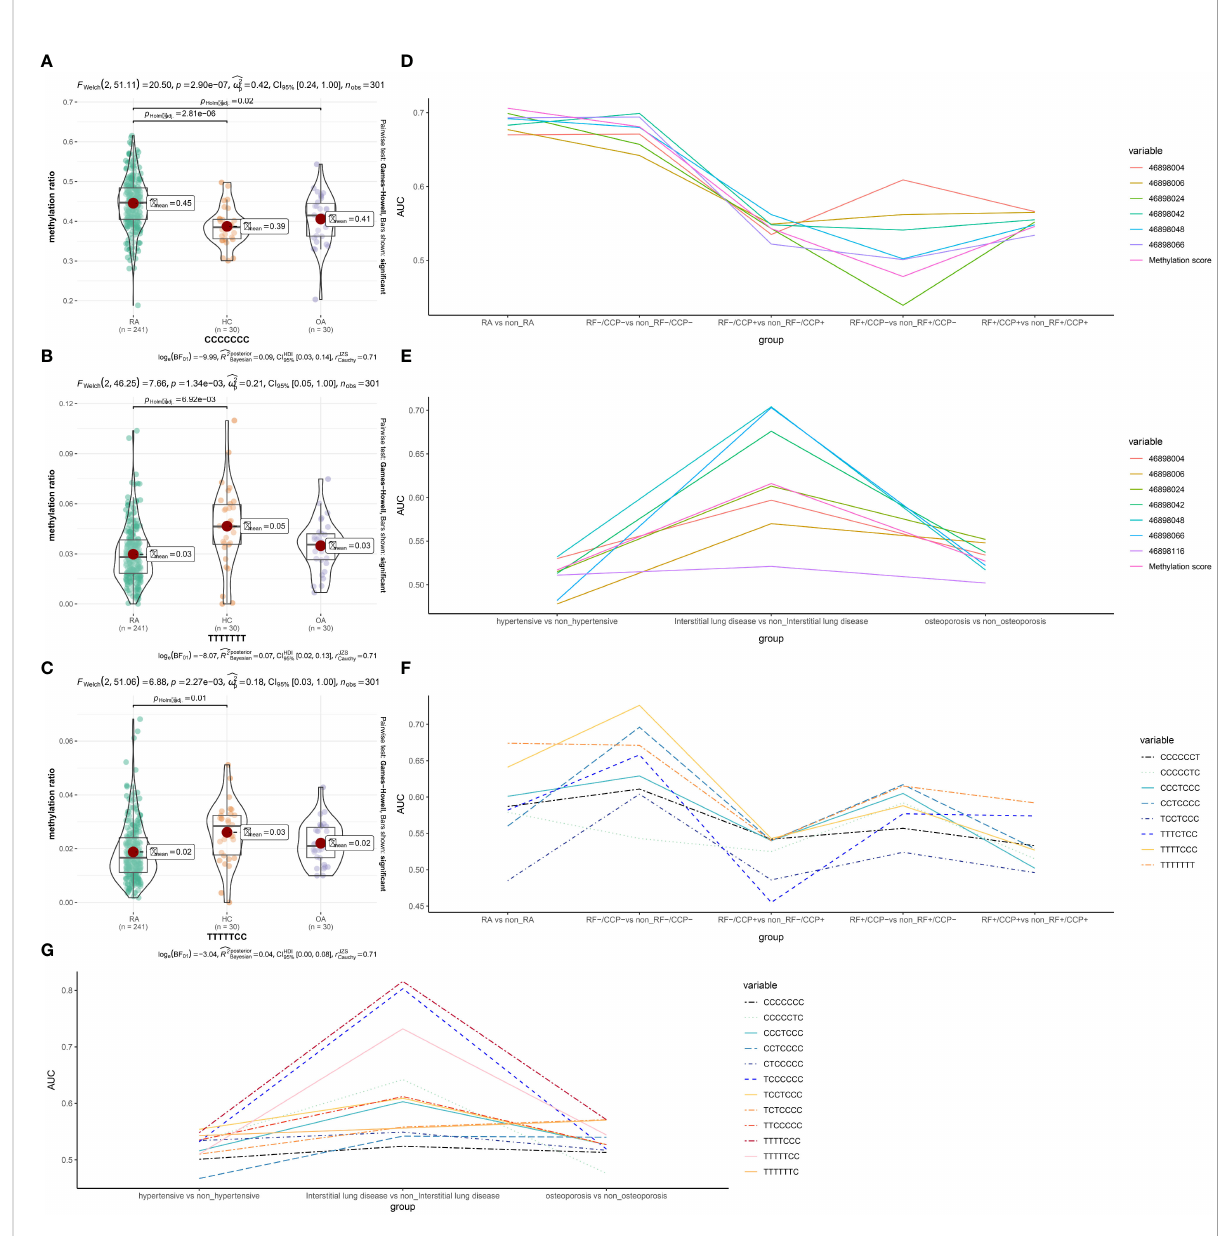
FIGURE 3 Speci fi city and accuracy of different CpG sites and haplotypes combined with RF or CCP for the diagnosis of RA and RA-related complications. (A-C) Haplotypes with signi fi cant differences (D-G) different CpG sites and haplotypes combined with RF or CCP for the diagnosis of RA-related complications. FDR < 0.05 is statistically signi fi cant. RA, rheumatoid arthritis; OA, osteoarthritis patients; HC, healthy